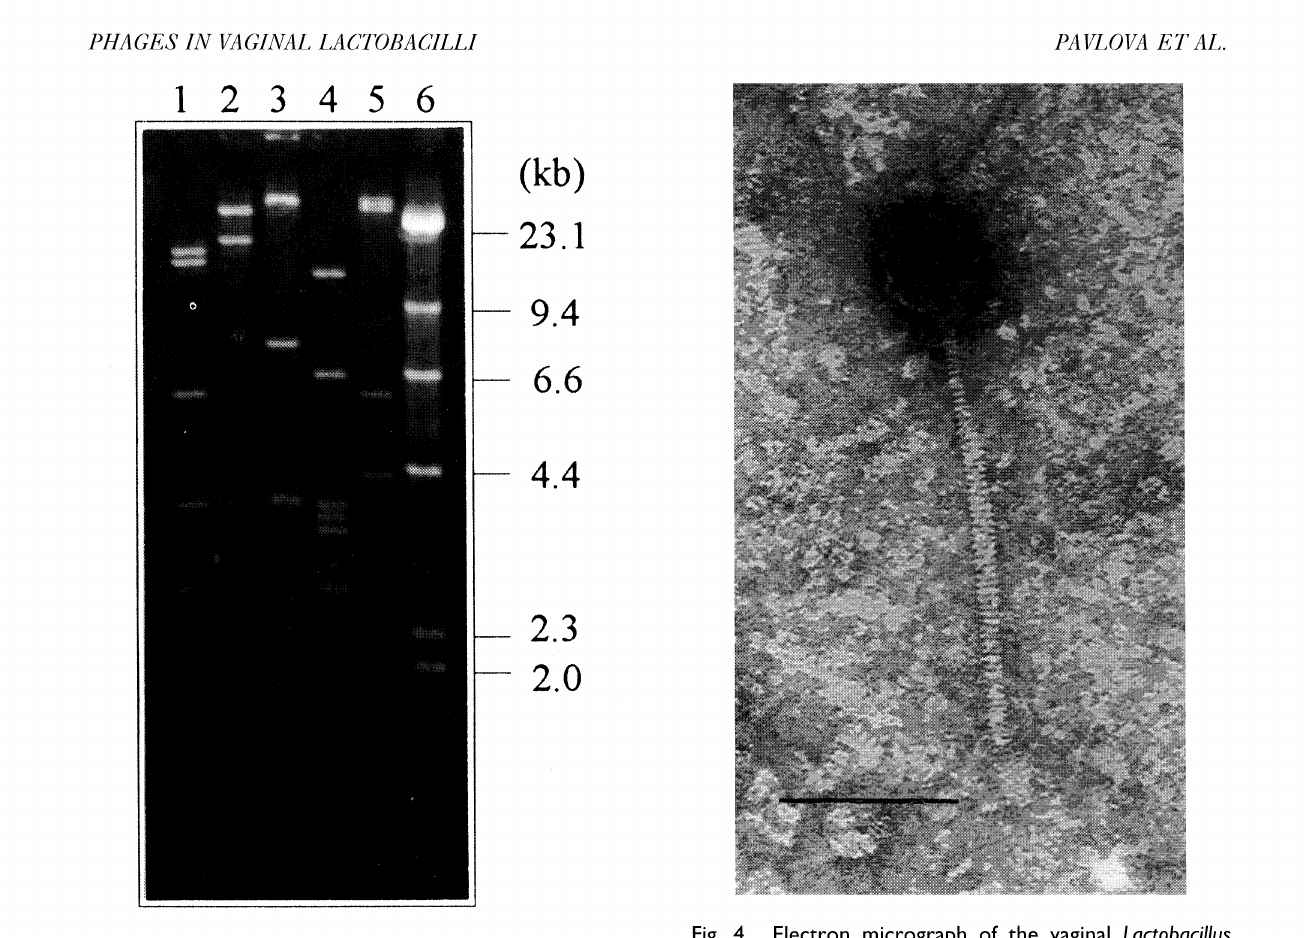
Fig. 3. Restriction analysis of vaginal Lactobacillus phage dpkc039 DNA. Bacteriophage +kc039 DNA was digested with Aval (lane I), BamHI (Lane 2), Bglll (lane 3), EcoRI (lane 4), and Sail (lane 5). A Hindlll digest of lambda DNA was used as the molecular weight standard (lane 6).